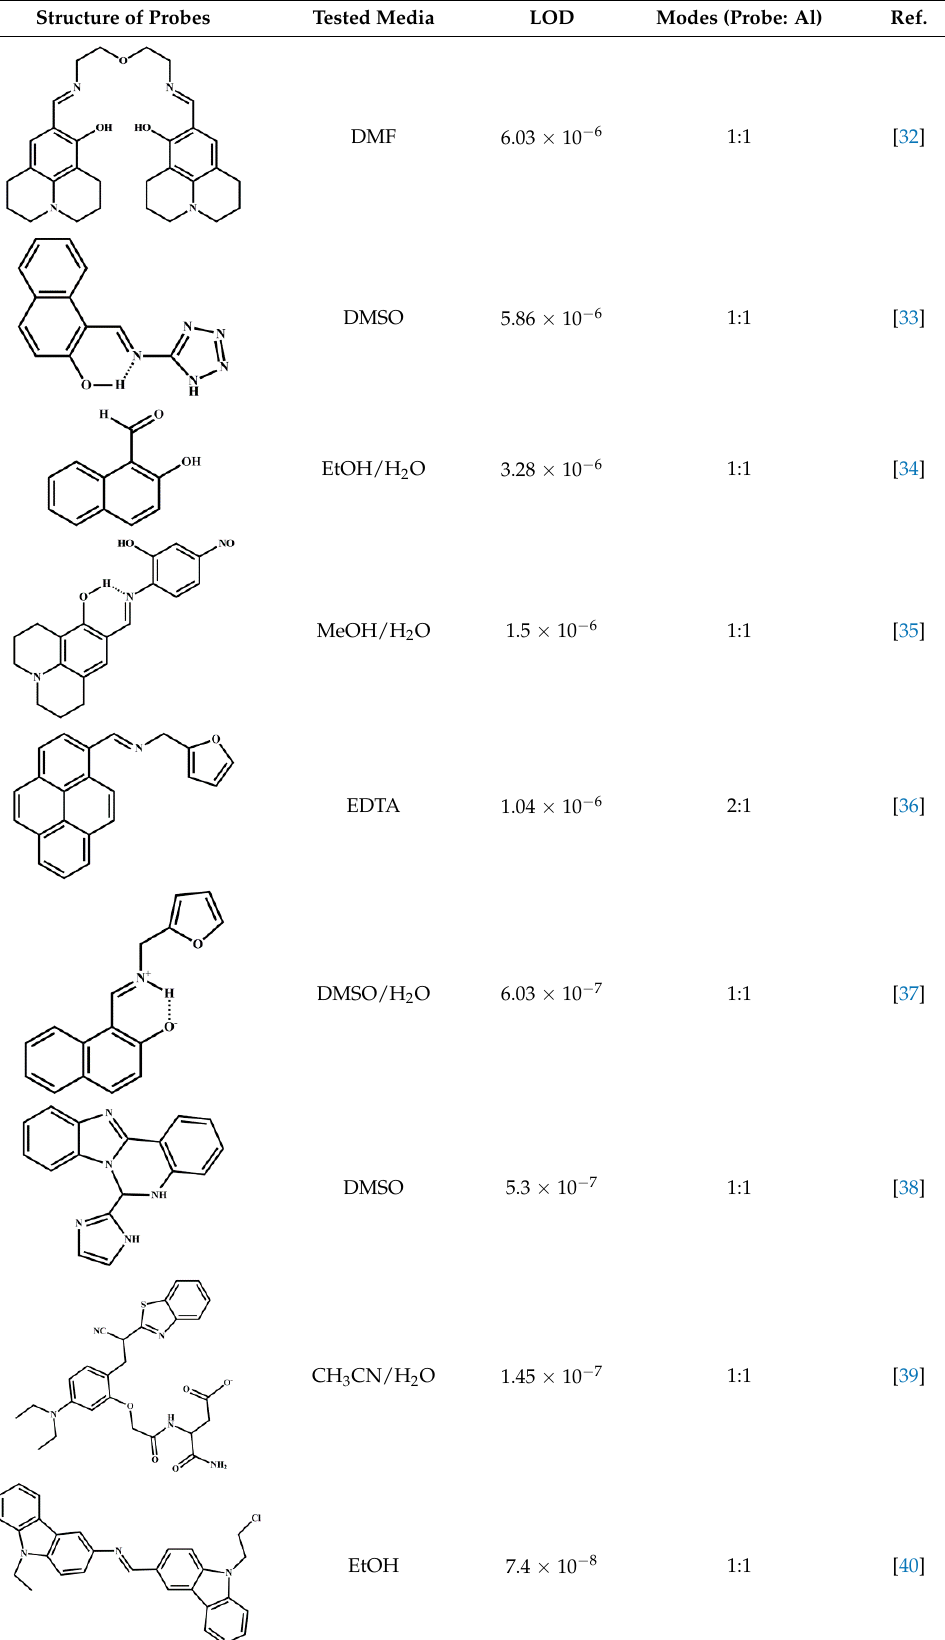
Figure 3. ( a , b ) Fluorescence spectra of L and S in the presence of increasing amounts of Al 3+ (0–150 μ M). ( c , d ) Plot of fluorescence intensities of L and S, respectively. Table 1. Comparison of some fluorescent probes for Al 3+ detection. Structure of Probes